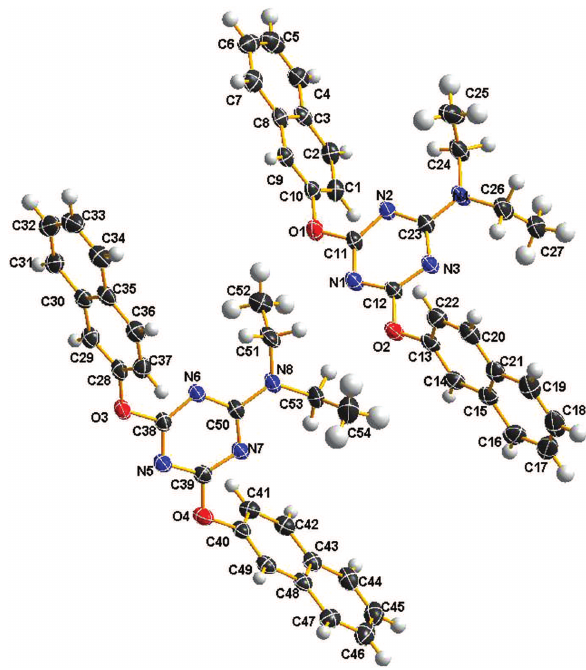
Table 1: Data collection and